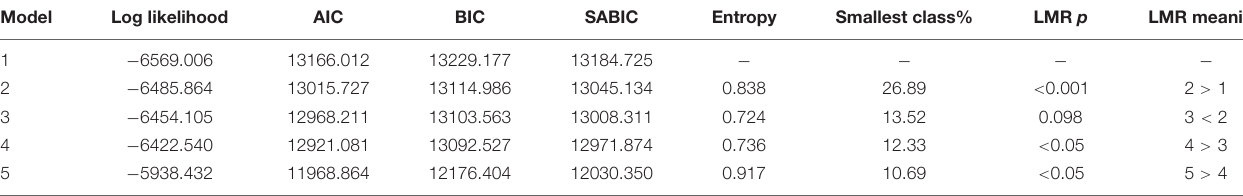
TABLE 1 | Latent profile analysis model fit measures and comparisons. Model